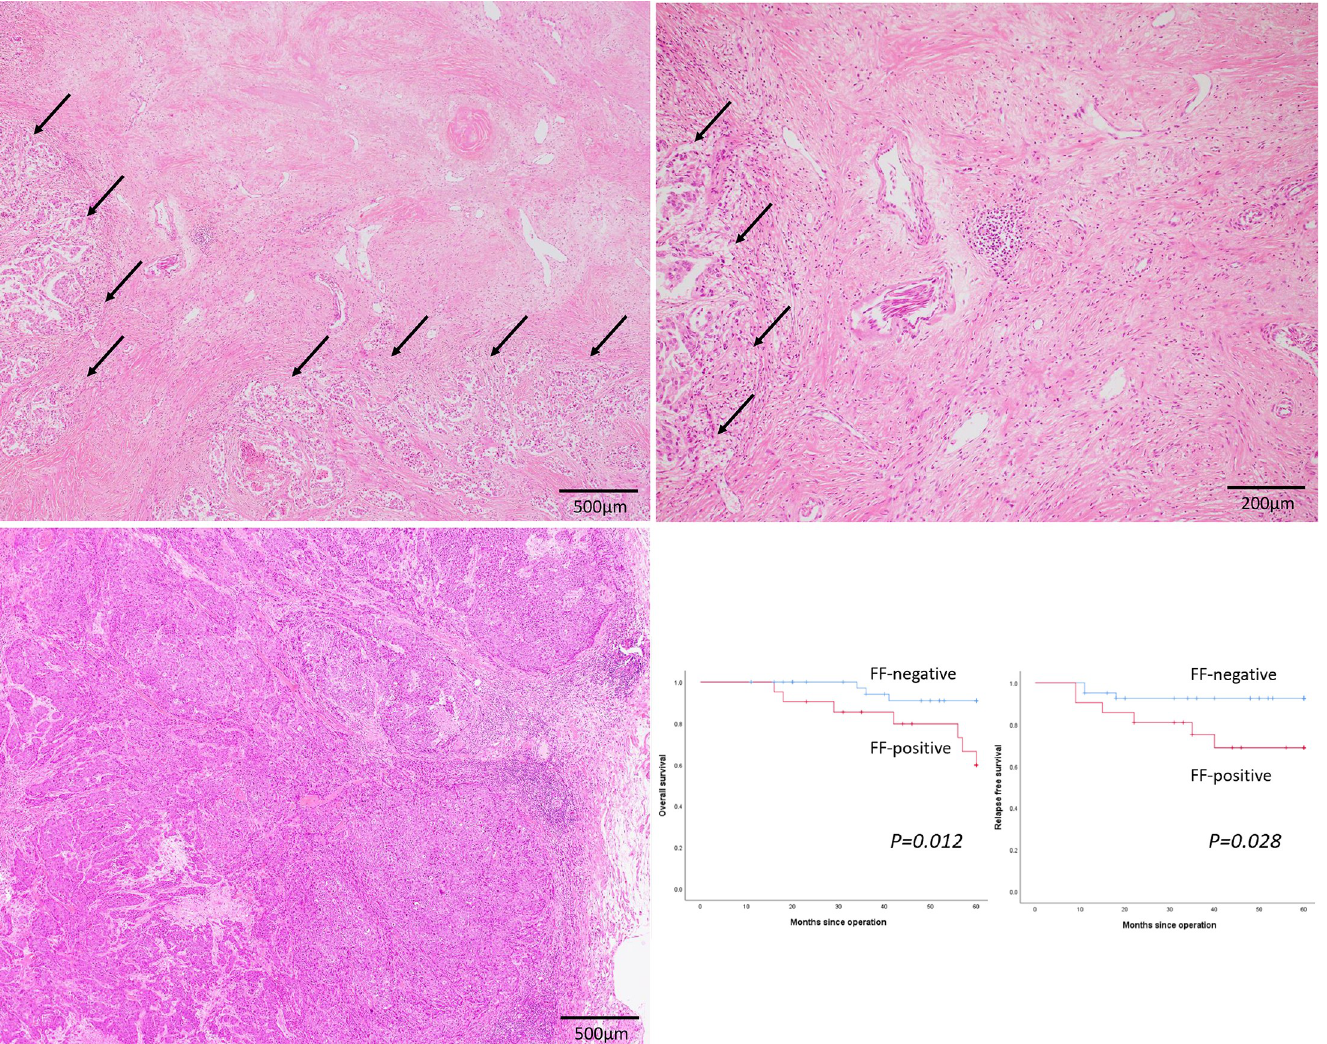
Fig 2. Fibrotic focus as an independent predictor of survival in patients with triple-negative breast cancer. (a) (b) Representative image of fibrotic focus (FF) in triple-negative breast cancer. Fibrotic area within the tumor containing collagen surrounded by a highly cellular zone of infiltrating carcinoma (arrows) (x 40 (a) and x 100 (b)). (c) No FF is observed within the tumor (x 40). (d) Kaplan-Meier curves for the overall survival (OS) and relapse-free survival (RFS) of triple-negative patients with breast cancer. OS (left) and RFS (right) curves among FF-positive (red line) and FF-negative (blue line)